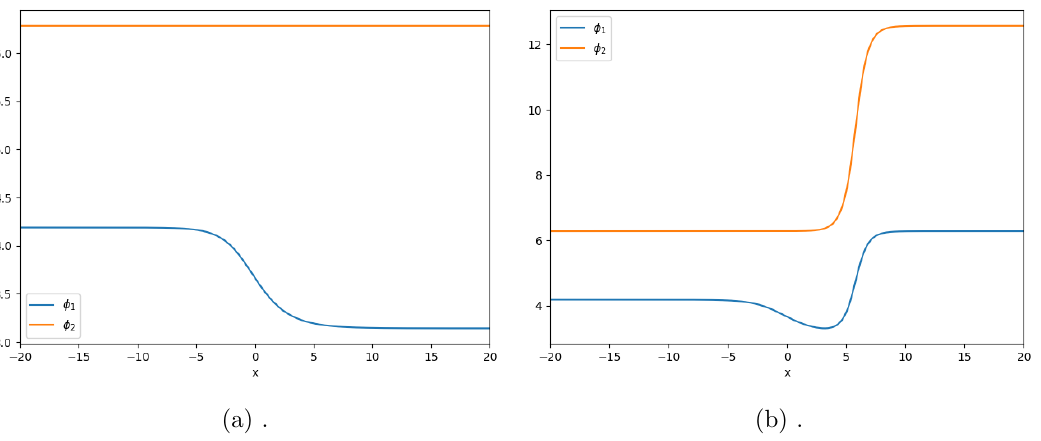
Figure 6. Two numerically calculated BPS states of the model (cid:13) i =